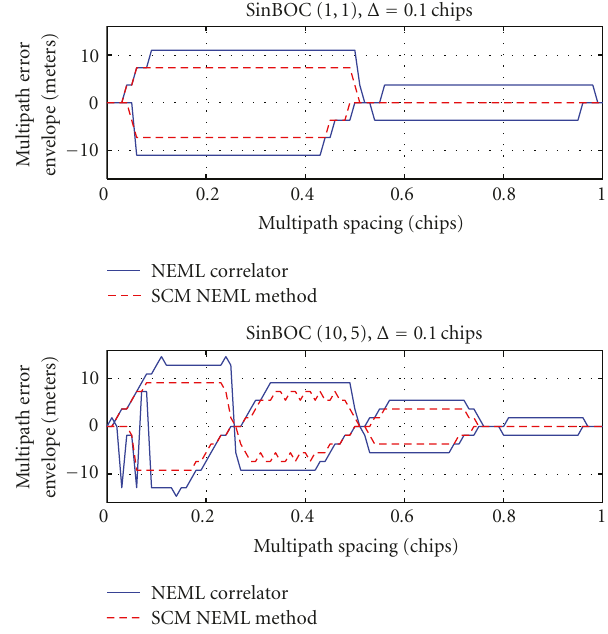
Figure 12: Multipath error envelopes (in meters): NEML correlator versus SCM NEML method, for two BOC-modulation cases and Δ = 0 . 1